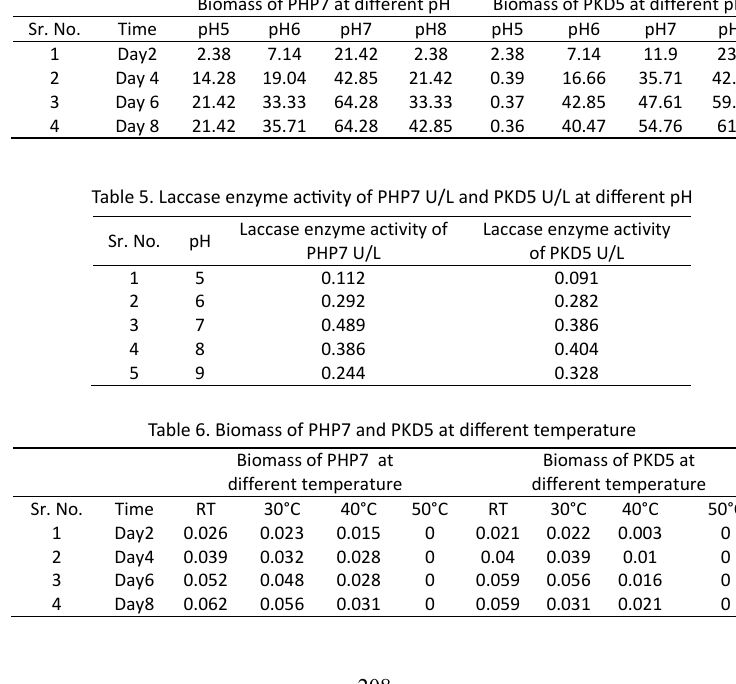
Table 4:Dye degradation of PHP7 and PKD5 at different pH Table 4.Dye degradation of PHP7 and PKD5 at different pH Biomass of PHP7 at different pH Biomass of PKD5 at different pH Sr. No.